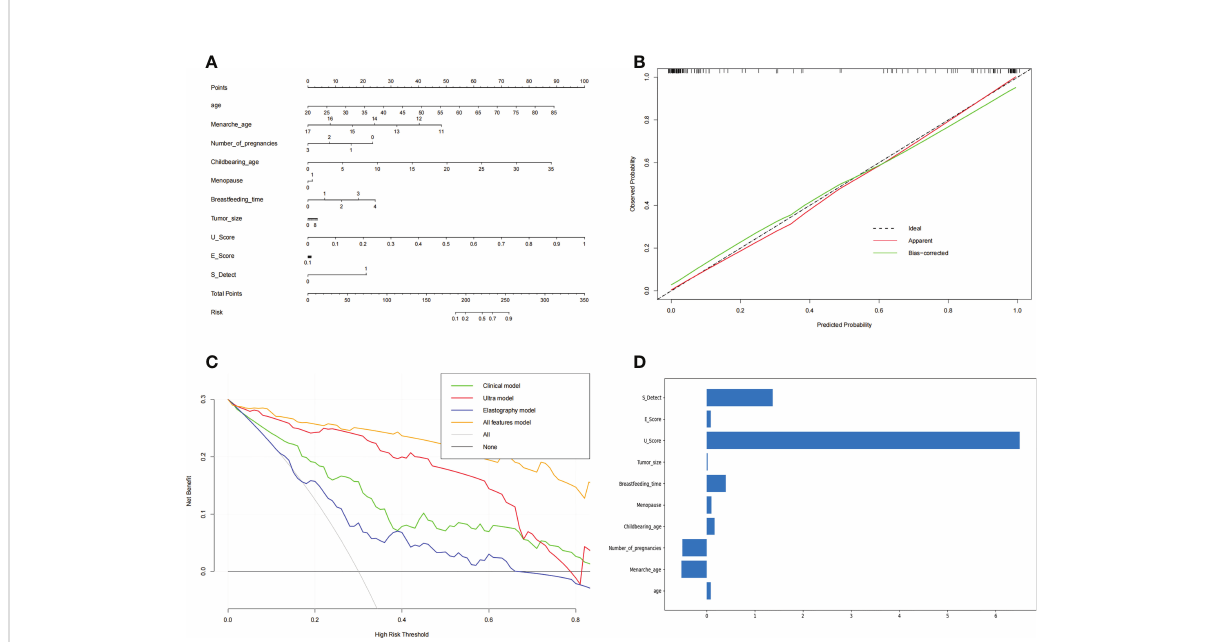
de fi ned as positive, and certain measures (such as predicting benign and malignant breast nodules) are taken. The balance of pros and cons then changes. The ordinate is the net bene fi t rate (NB) after subtracting the pros and cons. In addition to the curves of the four AI models, there are two gray lines in the